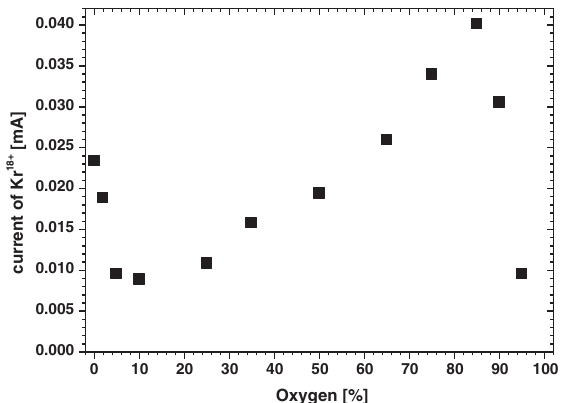
FIG. 4. Extracted current of Kr 18 þ ions for different oxygen contents.